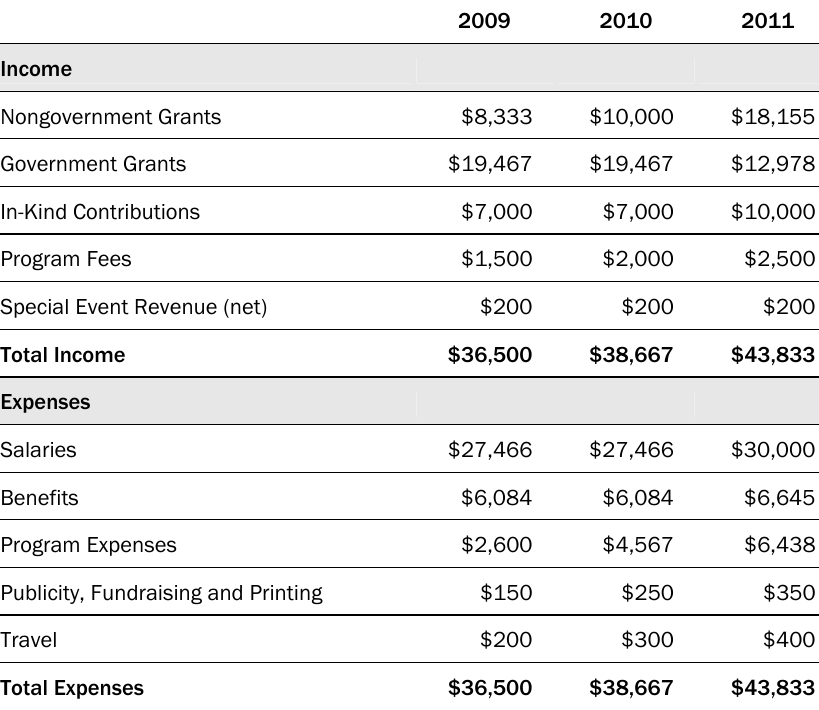
Figure 5. CGRN Summary Program Budget,